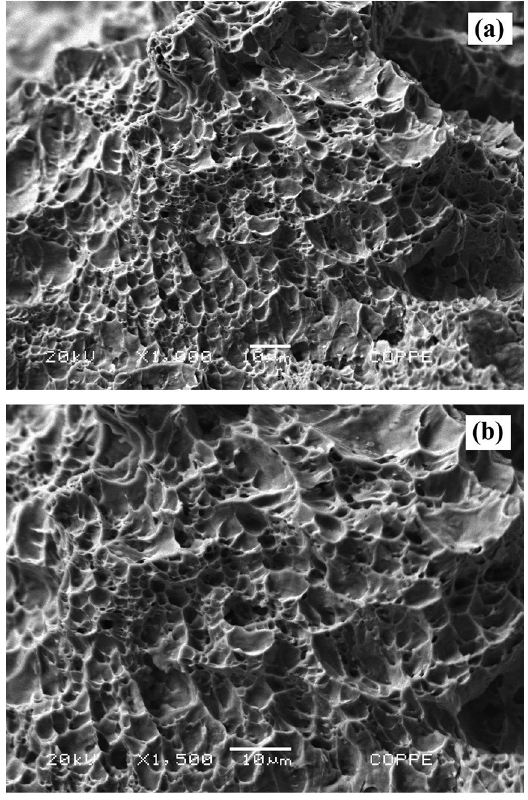
Figure 11: SEM of fracture surface after Charpy tests of hydrogenated (H) specimens of the base metal with heat treatment (HT) and hydrogenation (H): (a) rough aspects and microvoids; (b) small regions with quasi-cleavage aspects.